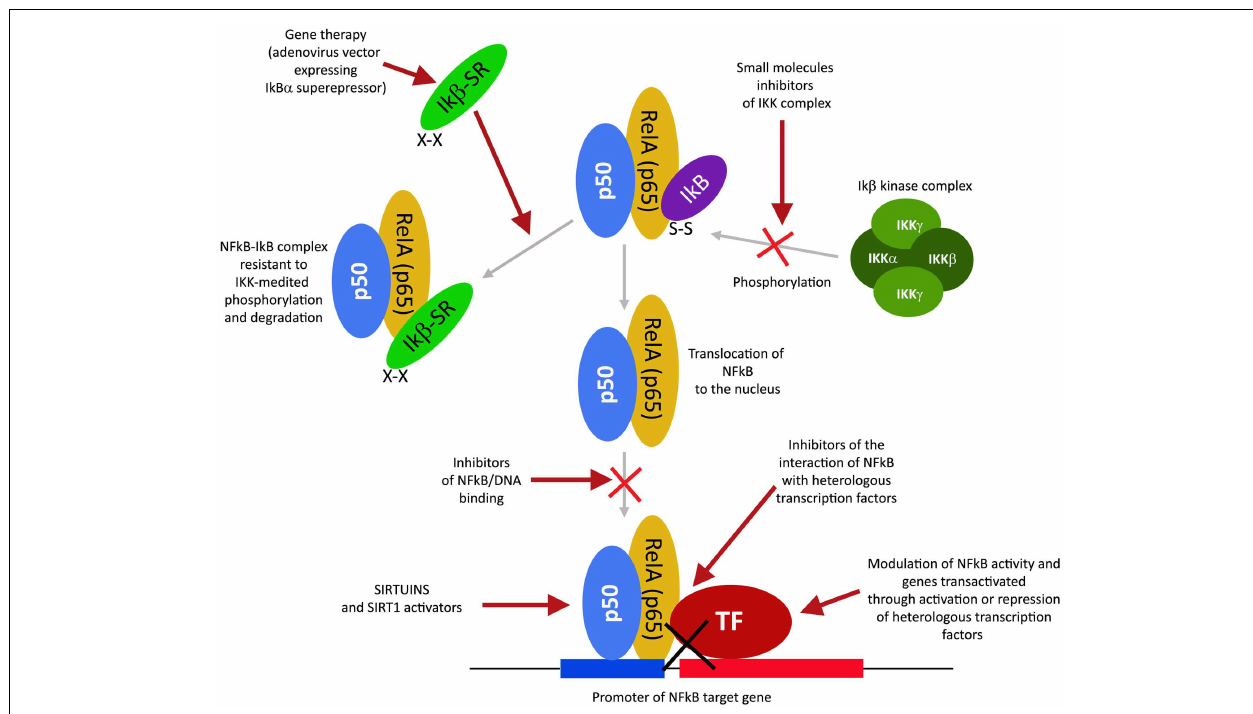
FIGURE 4 | NFkB activation pathway and its different inhibition